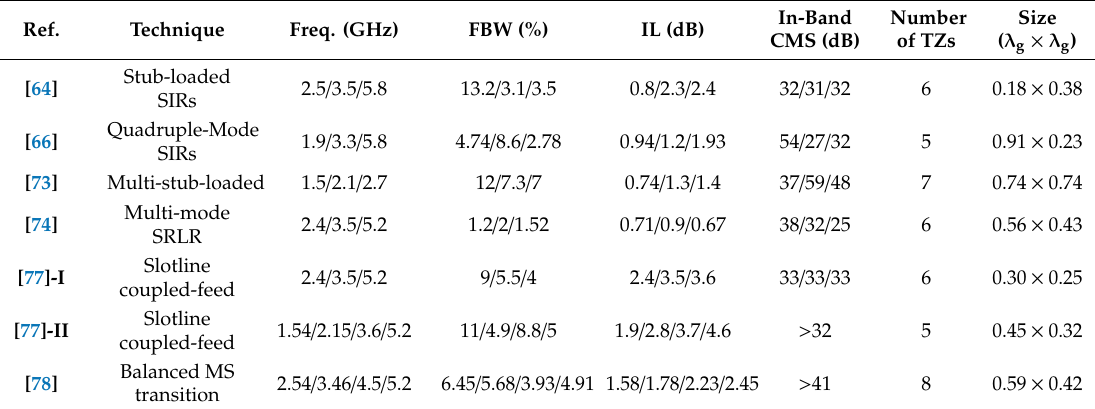
Table 3. Performance comparisons for some recent tri- and quad-band di ff erential microstrip BPFs.